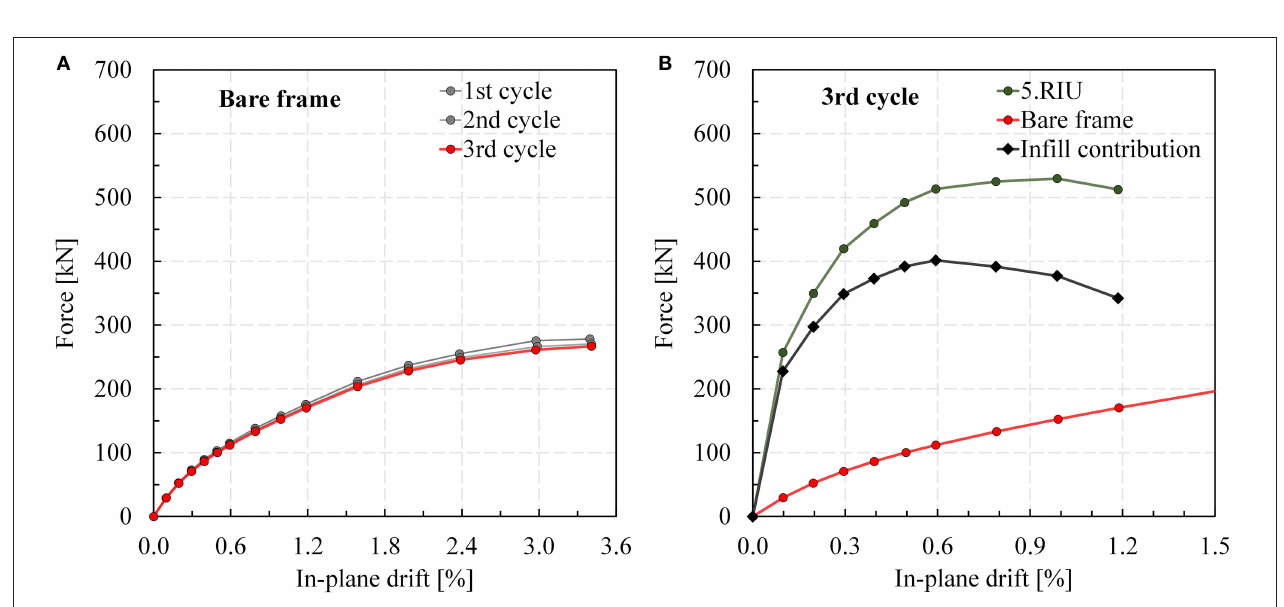
FIGURE 9 | In-plane tests (infill contribution): load-drift envelope curves (A) ; stiffness degradation (B) .